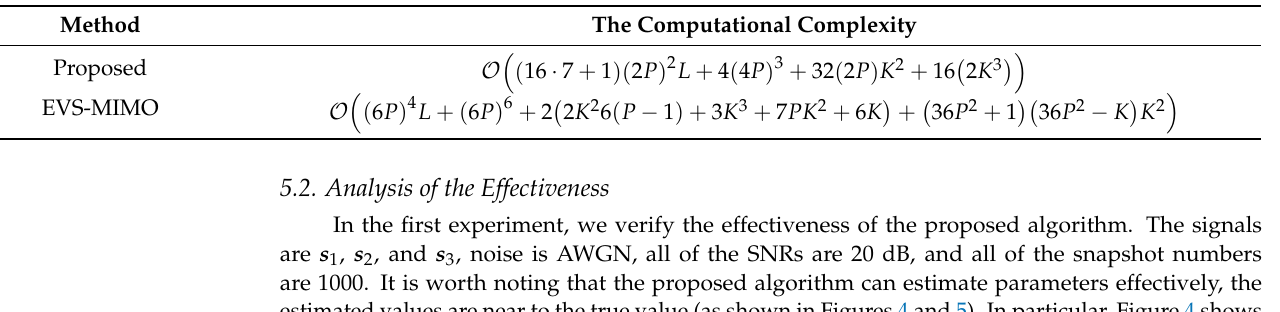
Table 2. Analysis of the computational complexity of the different